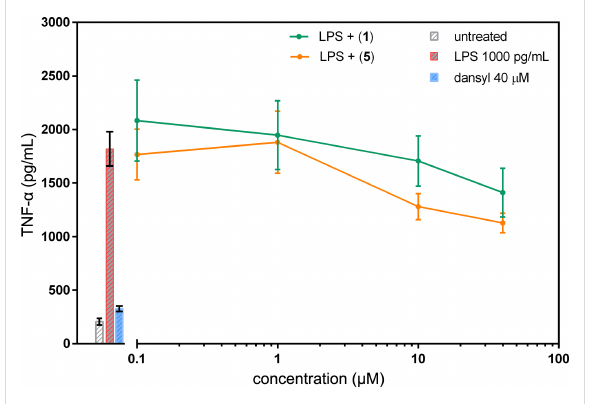
Figure 9: Evaluation of cytokine TNF- α secretion in rat peritoneal cells. Stimulation of primary cells was induced by 1000 pg·mL − 1 of LPS. Cells were cultured in the presence of archangelolide ( 1 ) and dansylarchangelolide 5 for 24 h. Cytokine secretion was detected by ELISA. The data are the means ± SEM of two independent experi- ments, n = 4.